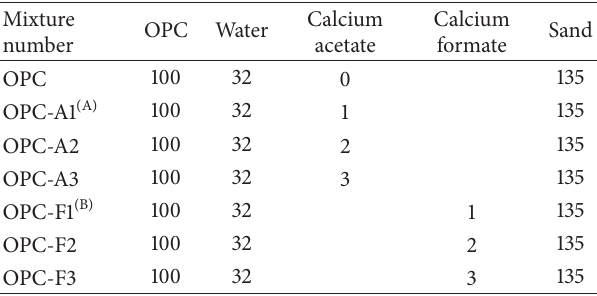
Table 7: Mixtures for paste and mortar